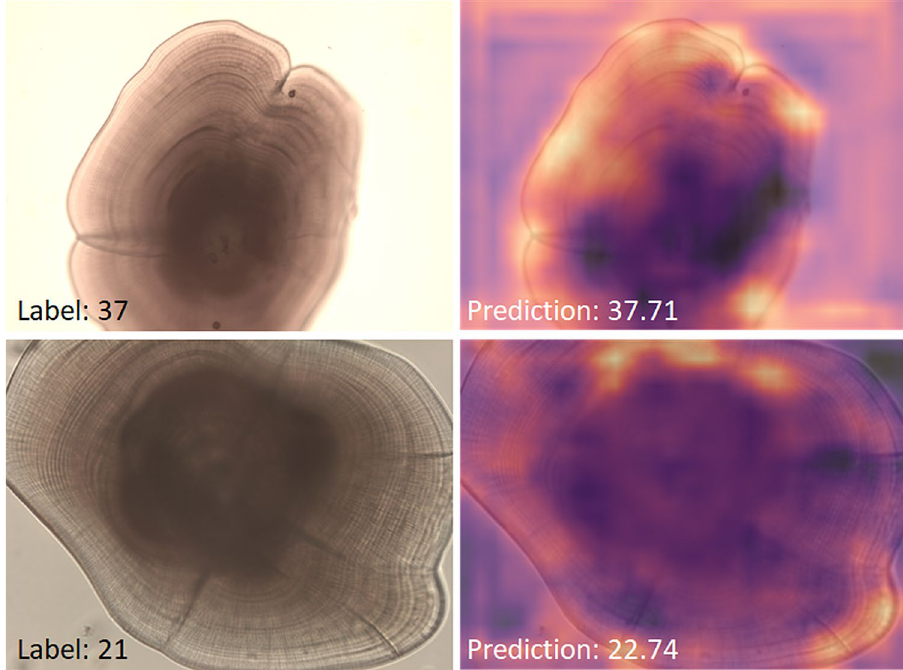
Figure 3. Examples of images (left) and CAMs (right), with good performance from the ring test set.